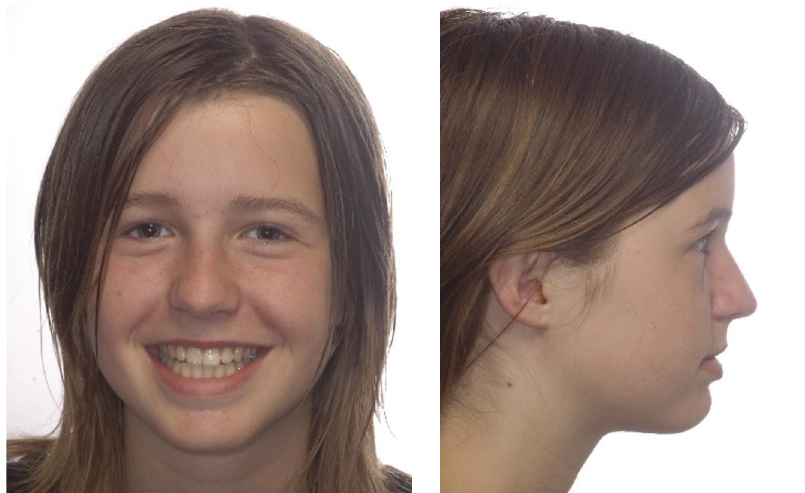
Figure 5: Posttreatment extraoral photographs.